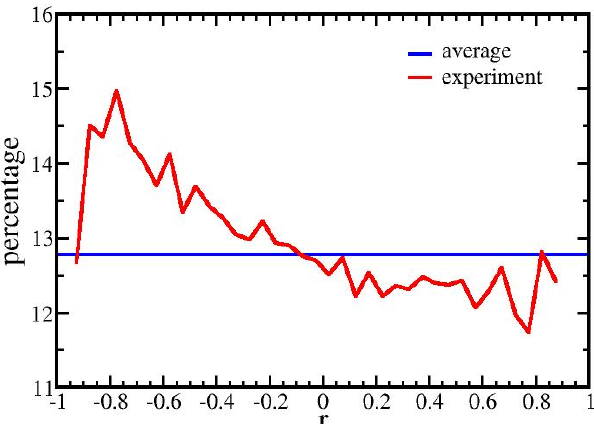
Figure 2. Percentage of predicted targets across a range of correlation coefficients. The percentage of targets over the range of correlation defined in Figureoˆ 1 decreases with the increasing correlation between miRNAs and mRNAs. This implies that the correlation indeed captures information about target prediction, and the negative slope might be related to direct targeting effect between miRNAs and mRNAs.